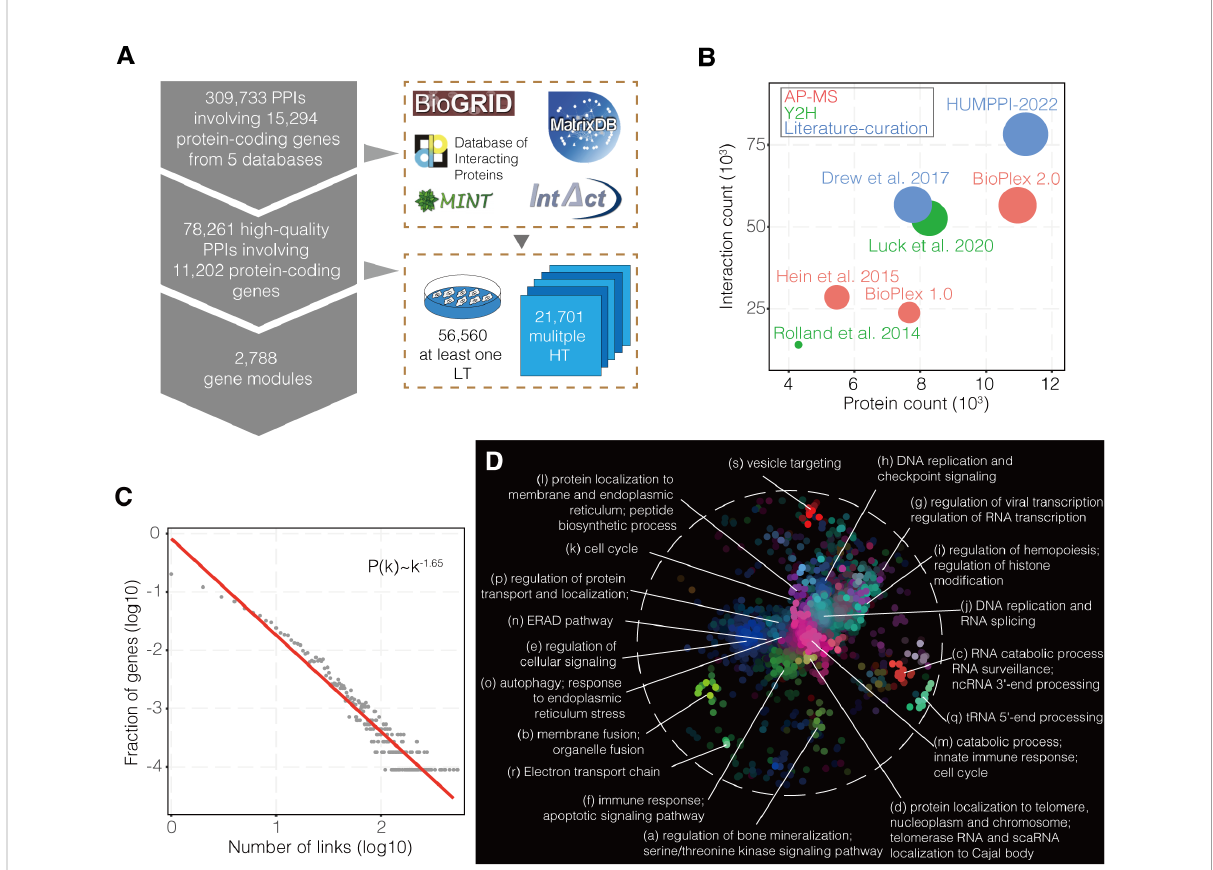
FIGURE 1 The construction of human protein-protein interaction network. (A) Acquisition of high-quality literature-curated PPIs and module statistics. HT, High-Throughput; LT, Low-Throughput. (B) Comparisons with interaction networks derived from HT approaches and literature-curation method with respect to number of protein-coding gene and interaction counts. Circle area is proportional to interaction counts, while shading denotes the experimental strategy. AP-MS, af fi nity-puri fi cation mass spectrometry; Y2H, yeast two-hybrid assay. (C) Power-law degree distribution of HUMPPI-2022. (D) The functional domains in HUMPPI-2022. All region-speci fi c GO terms were combined into 19 domains based on the similarity of their enrichment landscapes. Different colors represent different functional